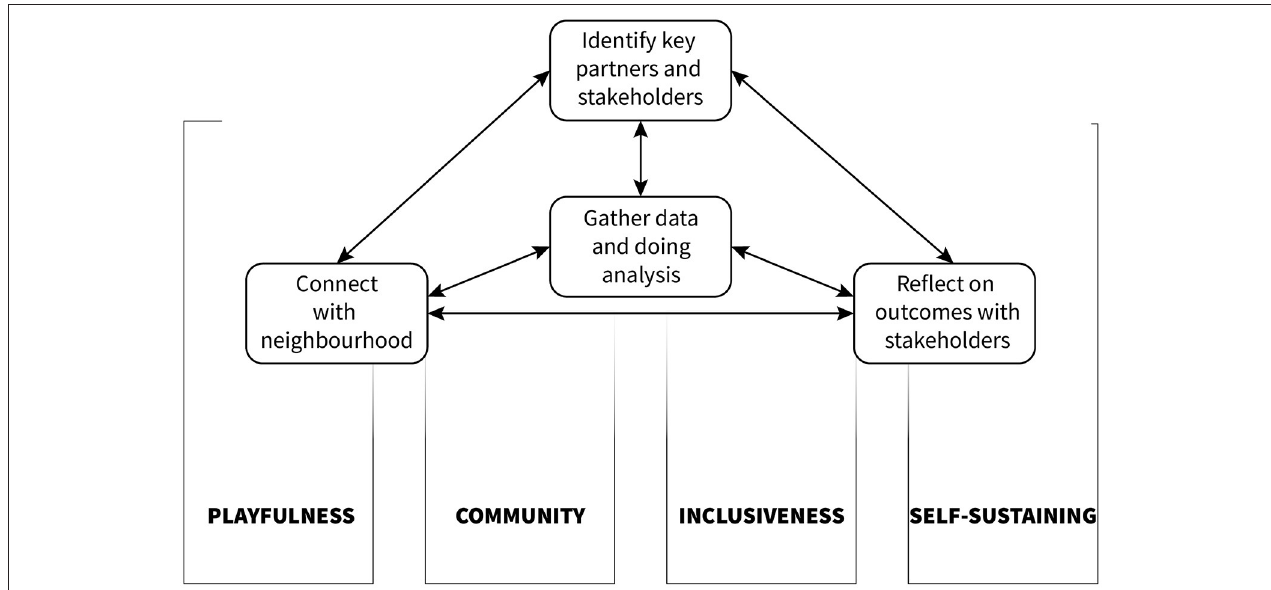
FIGURE 1 | The design framework proposed in this paper comprises four activities grounded on four